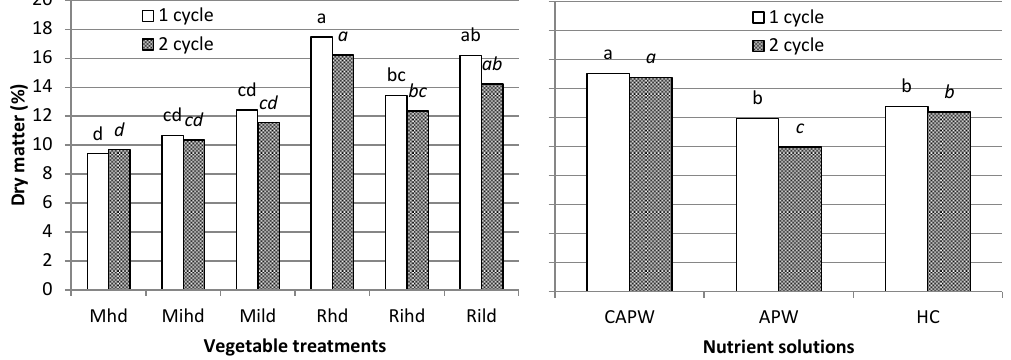
Figure 10. Effect of vegetable treatments and nutrient solutions on dry matter percentage for two growth cycles. M HD : mizuna high density; M IHD : mizuna intercropped high density; M ILD : Mizuna intercropped low density; R HD : rocket salad high density; R IHD : rocket salad intercropped high density; R ILD : rocket salad low density; HC: hydroponic control; APW: aquaponic water; CAPW: complemented aquaponic water. Different letters on the same DAS indicate significant differences, with p < 0.05, based on Tukey HSD Test.